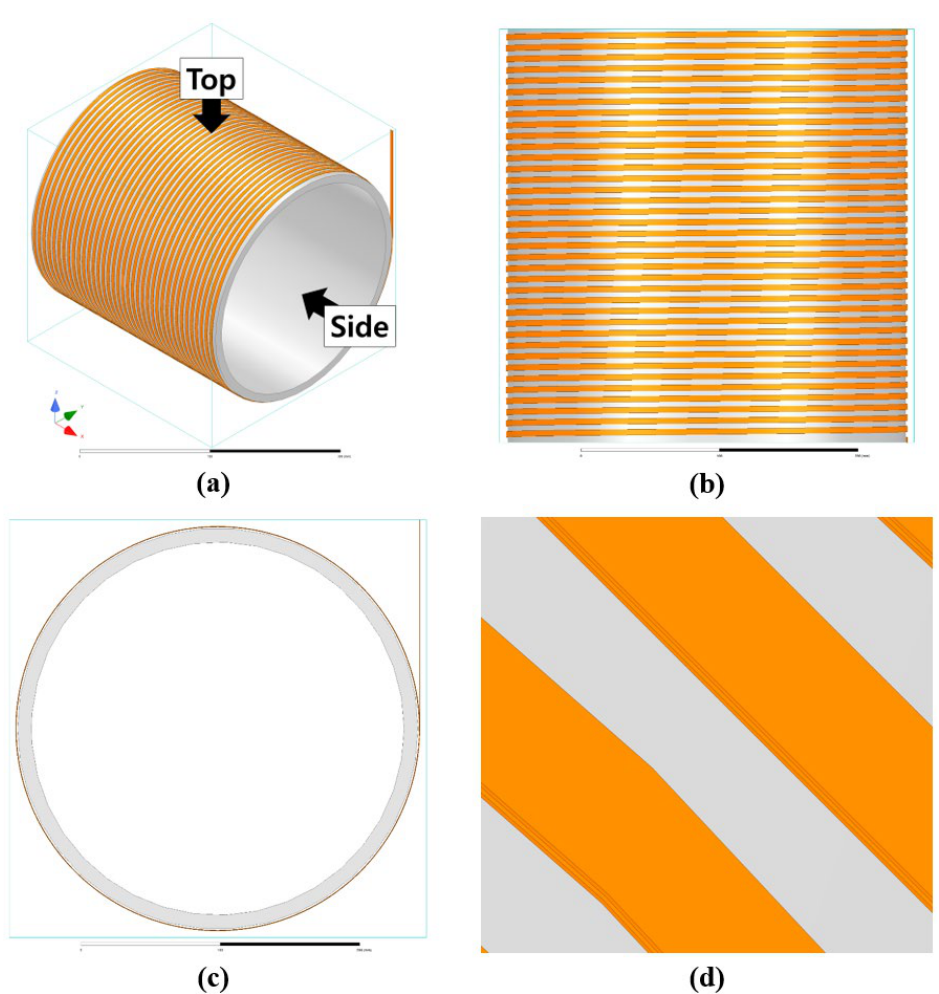
Figure 8. Superconducting module modeling with the bifilar-helical type: ( a ) overall, ( b ) top view, ( c ) side view, ( d ) bifilar view.